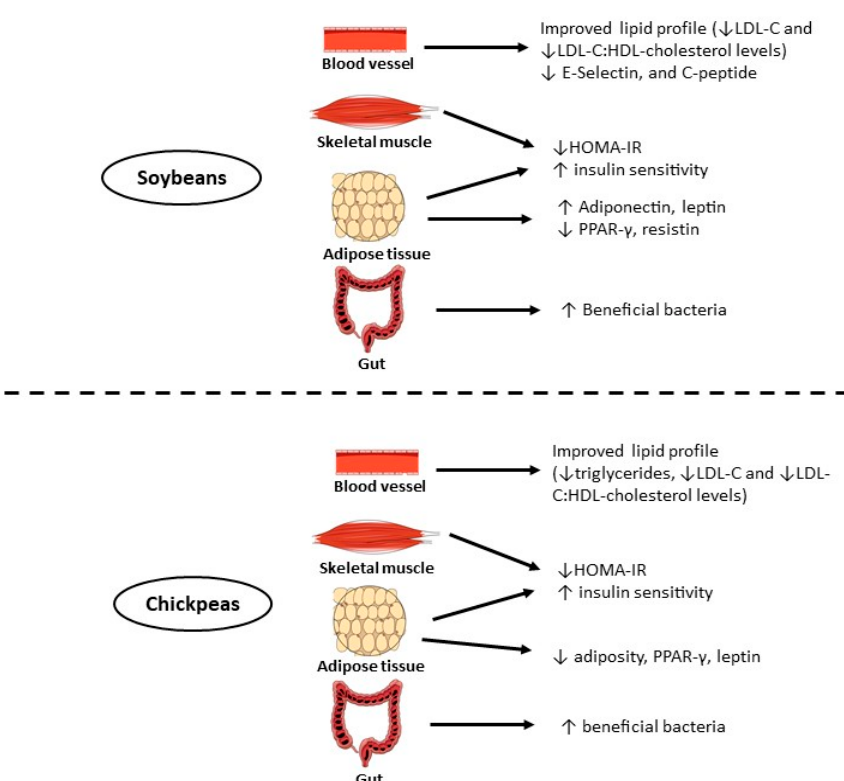
Figure 2. Proposed mechanisms of action for the reduction of insulin resistance by soybeans and chickpeas. Abbreviations: ↓ , decrease; ↑ , increase; PPAR- γ , peroxisomeproliferator-activatedreceptor- γ ; chickpeas. Abbreviations: ↓ , decrease; ↑ , increase; PPAR- γ , peroxisome proliferator-activated HOMA-IR, homeostasis model assessment-insulin resistance; LDL-c: low-density lipoprotein receptor- γ ; HOMA-IR, homeostasis model assessment-insulin resistance; LDL-c: low-density cholesterol; HDL: high-density lipoprotein cholesterol; HDL: high-density lipoprotein.